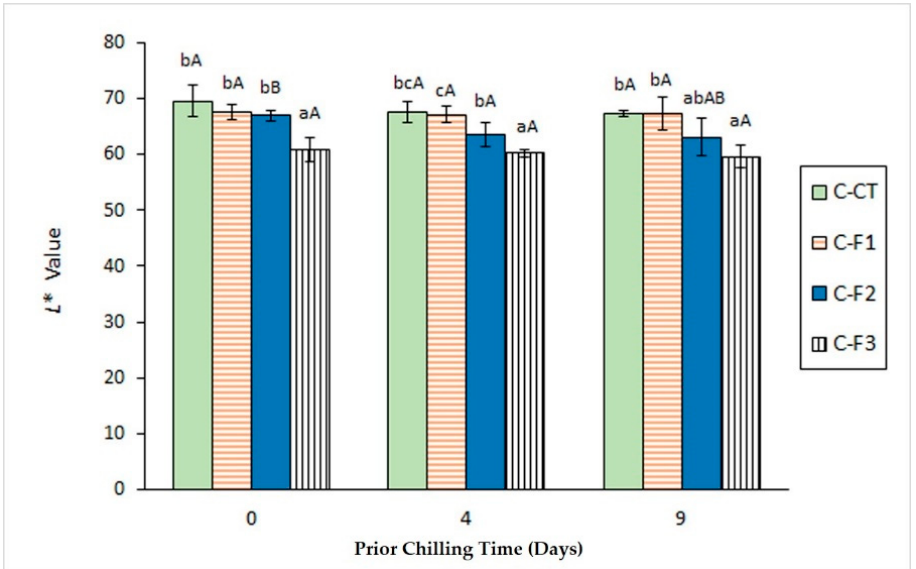
Figure 2. Determination of L * colour value in canned mackerel previously subjected to different chilling times and packaged with different alga extract concentrations. Mean values of five replicates ( n = 5). Standard deviations are indicated by bars. Initial raw fish value: 38.30 ± 2.41. For each chilling time, different low ‐ case letters (a, b, c) denote significant differences ( p < 0.05) as a result of the alga extract concentration. For each alga extract concentration, different capital letters (A, B) denote significant differences ( p < 0.05) by effect of the chilling time. Alga extract concentrations in packaging media as expressed in Figure 1.